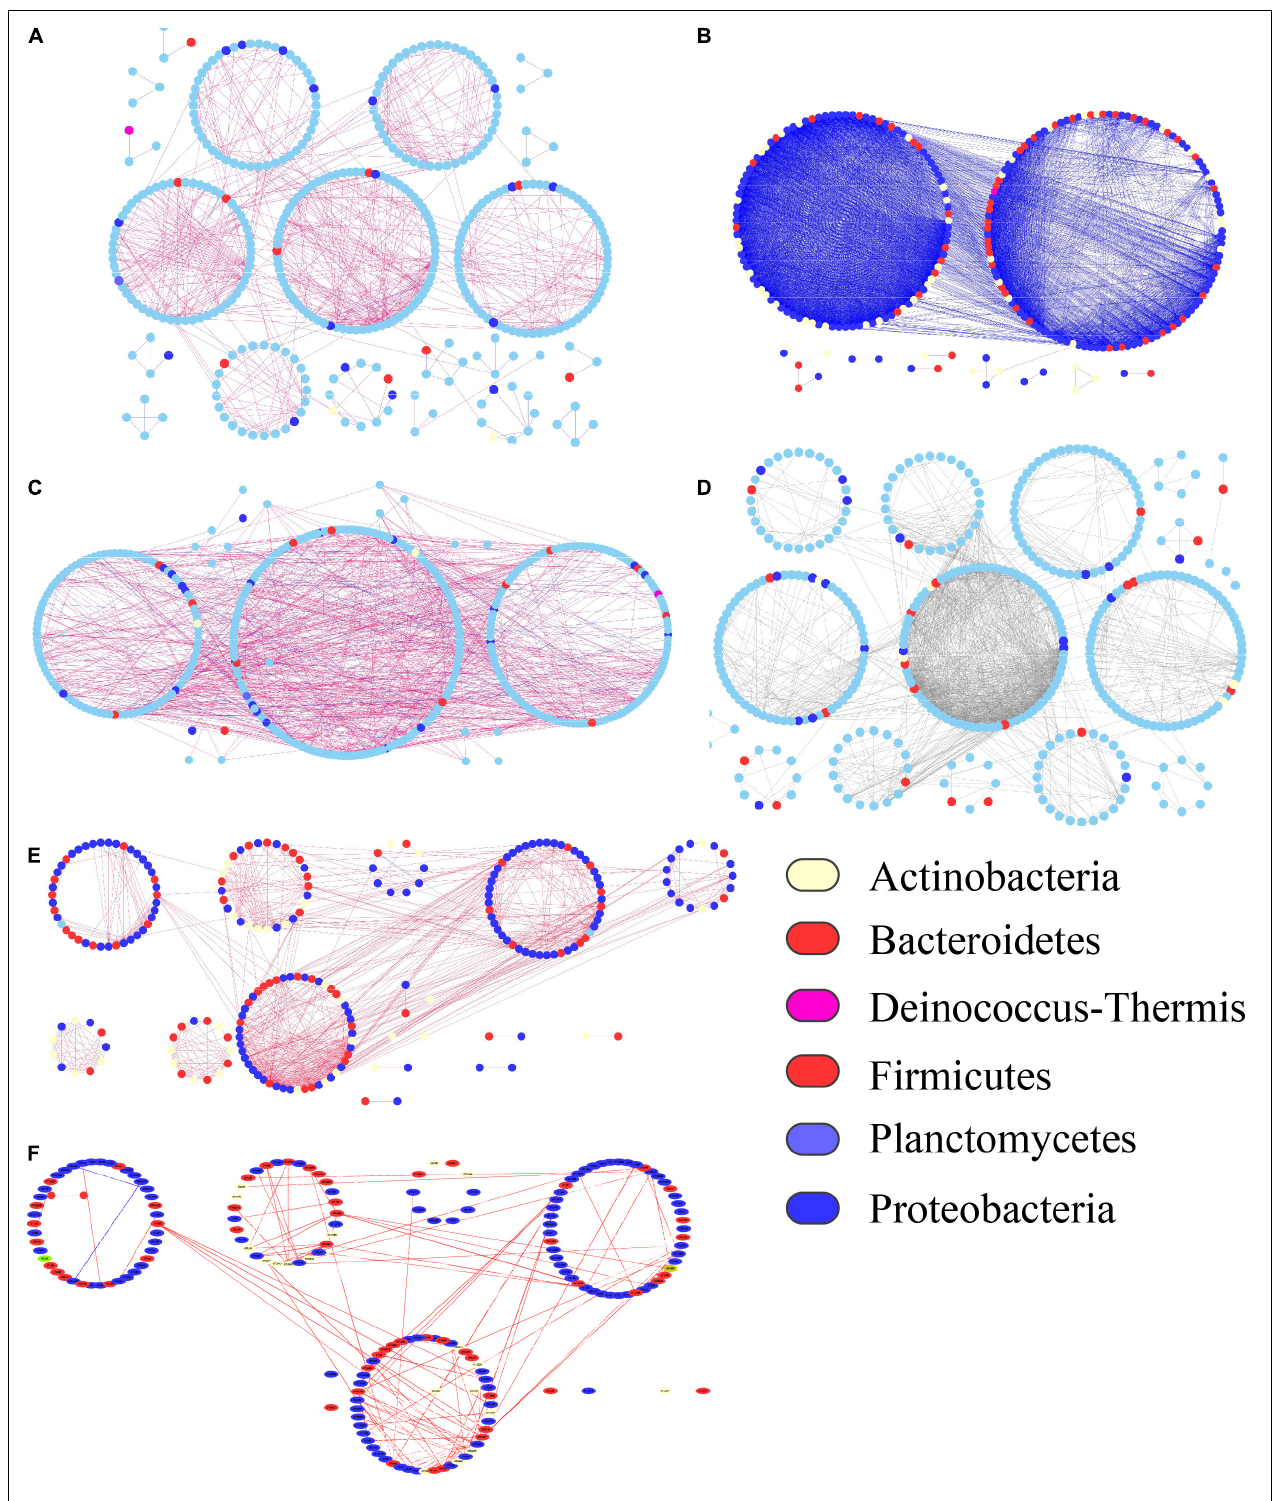
FIGURE 6 | Visualized networks of microbial co-occurrence patterns. (A) T1OH, (B) T4OH, (C) T4OI, (D) TICH, (E) T3CH, and (F) T3CI. TIOH stands for initially healthy plants in the organic system greenhouse, T4OH stands for healthy plants in the organic system greenhouse, T4OI stands for diseased plants in the organic system greenhouse, TICH stands for initially healthy, T3CH stands for healthy at last, and T3CI stands for diseased at last in the conventional greenhouse. T1, seedling phase; T3, fruiting phase; T4, harvesting phase.